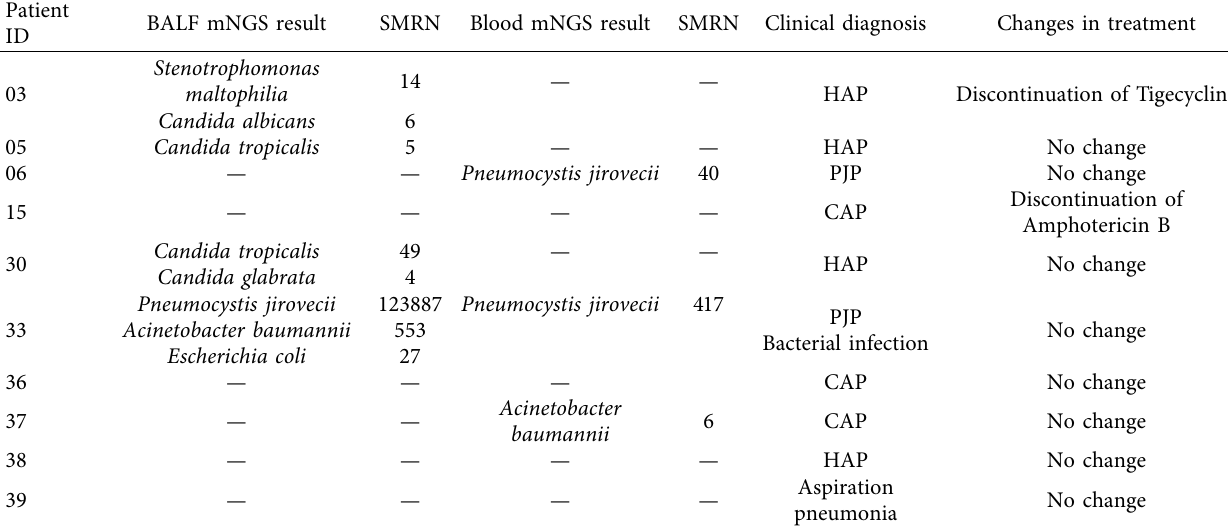
Table 2: The mNGS results of bacteria and fungi for patients without paired BALF culture result ( n � 10).